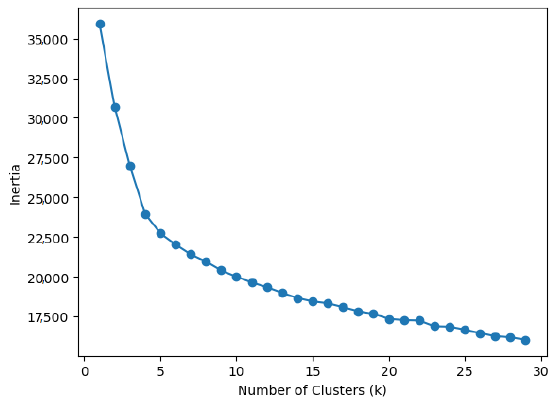
Figure 6. Inertia value according to the number of clusters.